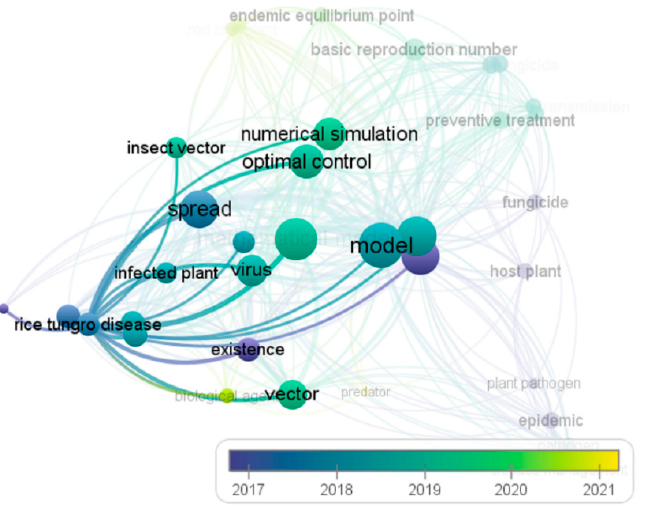
Figure 11. Mapping a mathematical model of the spread of tungro virus in rice plants.